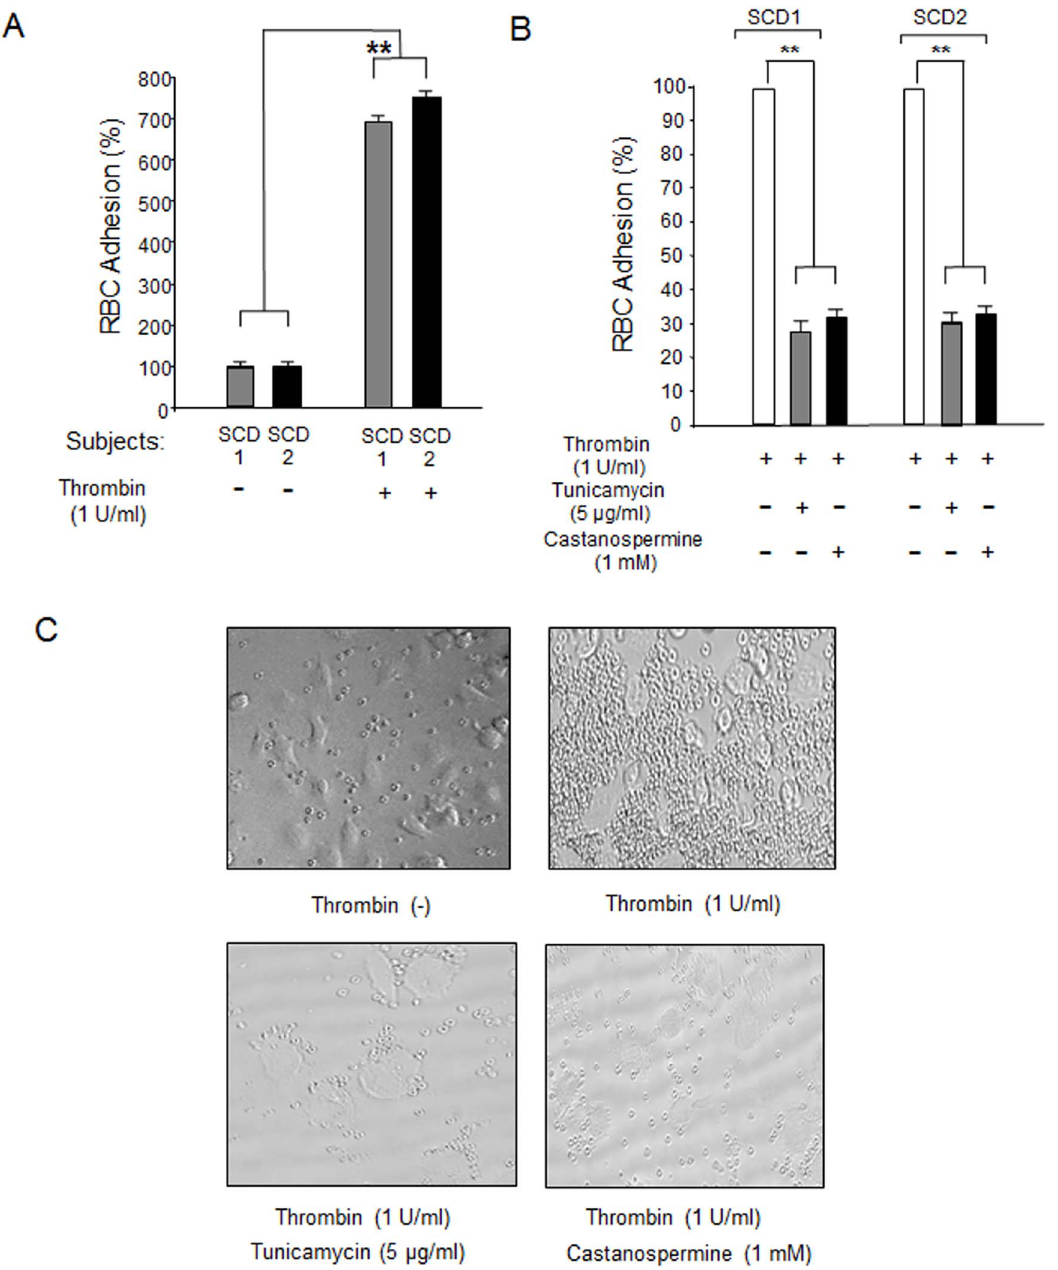
Figure 4. Glycosylation inhibitors block thrombin-induced sRBC adhesion to HUVECs. A . Thrombin induces sRBC adhesion to HUVECs. sRBCs were prepared from two sickle cell model mice (SCD 1 & SCD 2) [26]. HUVECs were treated with 1 U/mL thrombin for 5 minutes after which sRBCs were added. The level of sRBC adhesion to untreated HUVECs was set to 100%. **, p , 0.0001 B . Glycosylation inhibitors decrease thrombin- induced sRBC adhesion to HUVECs. HUVECs were pretreated with glycosylation inhibitors for 48 hours and P-selectin expression was stimulated by 1 U/mL thrombin. sRBCs were then added to HUVECs for adhesion assays. The levels of sRBC adhesion to HUVECs that were not treated with glycosylation inhibitor but stimulated with thrombin were set to 100%. **, p , 0.0001 C . Representative microscopic images (x10 magnification) showing sRBC adhesion to HUVECs. Note that both tunicamycin and castanospermine inhibit sRBC adhesion to thrombin-activated HUVECs.